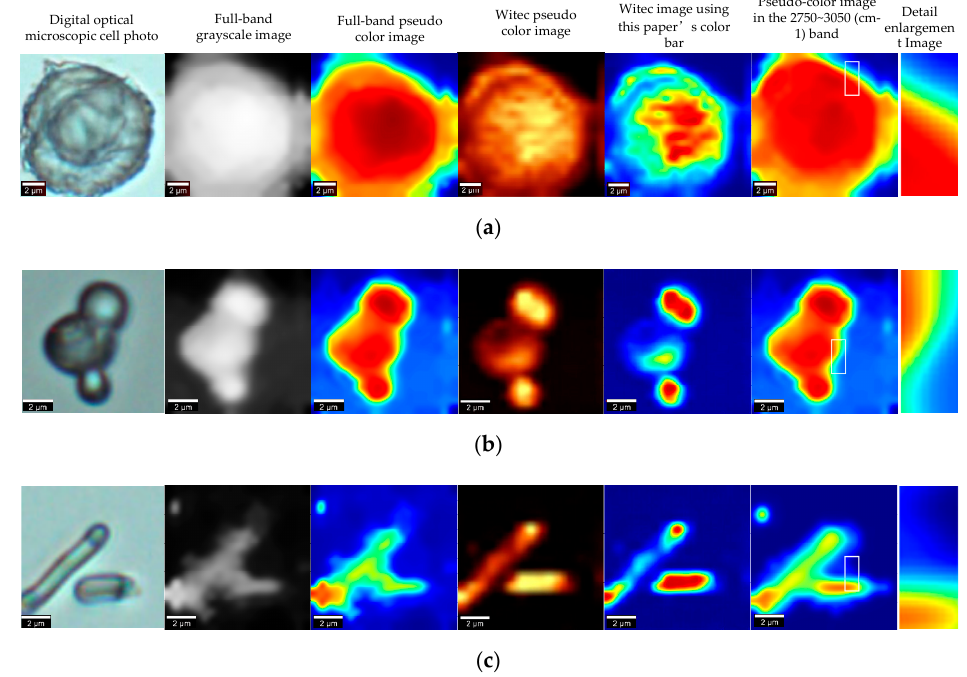
Figure 21. ( a ) Escherichia coli (dh5a strain), integral power is 10.98 mw, integration time is 2 s, integral number is 2, lens parameter is 600 g / mm. ( b ) yeast cells (Yeast), integral power is 1.5 mw, integration time is 5 s, integral number is 2 lens parameter is 600 g / mm. ( c ) human colon cancer cells (hct116 cell line), integral power is 1.5 mw, integration time is 5 s, integral number is 2, lens parameter is 600 g /